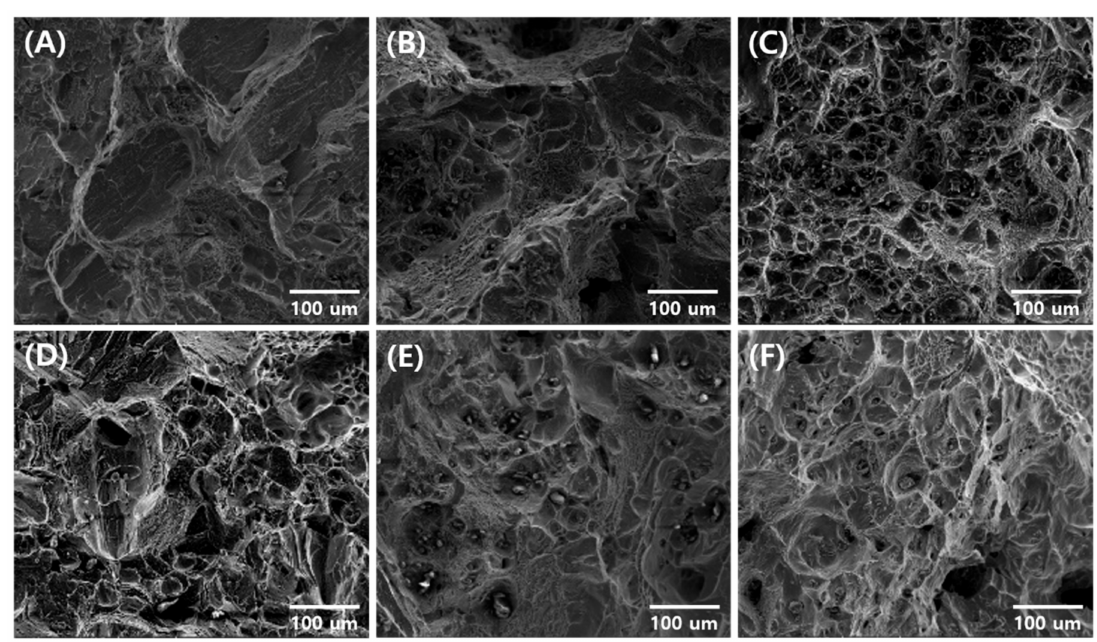
Figure 9. High-magnification FE-SEM images fracture surfaces of BDSS ( A – C ) and GDSS ( D – F ) after